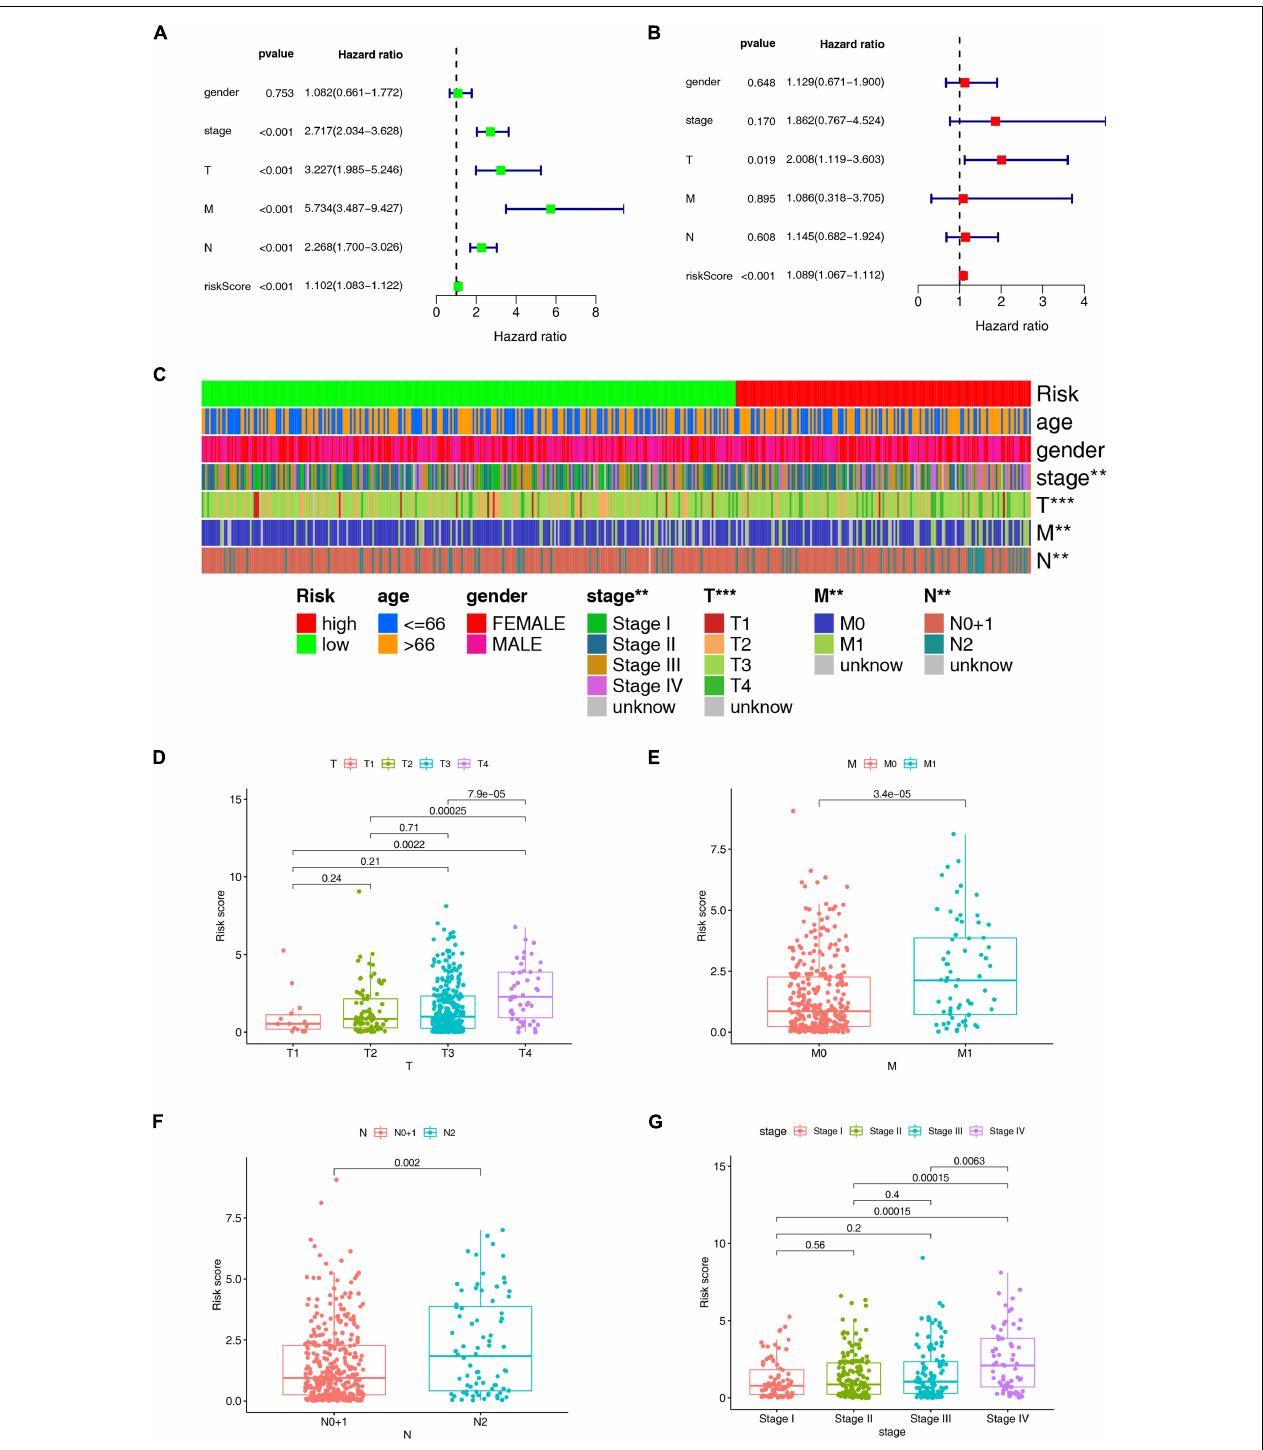
FIGURE 6 | Evaluation and clinical relevance analysis of the risk model. (A) Forest plots of univariate Cox hazard ratio analysis revealed that pathologic tumor stage ( p < 0.001, HR = 2.717, 95% CI [2.034–3.628]), T stage ( p < 0.001, HR = 3.227, 95% CI [1.985–5.246]), N stage ( p < 0.001, HR = 2.268, 95% CI [1.700–3.026]), M stage ( p < 0.001, HR = 5.734, 95% CI [3.487–9.427]), and riskScore ( p < 0.001, HR = 1.102, 95% CI [1.083–1.122]) were statistically different. (B) Forest plots of multivariate Cox hazard ratio analysis demonstrated that only T stage (p = 0.019, HR = 2.008, 95% CI [1.119–3.603]) and riskScore ( p < 0.001, HR = 1.089, 95%